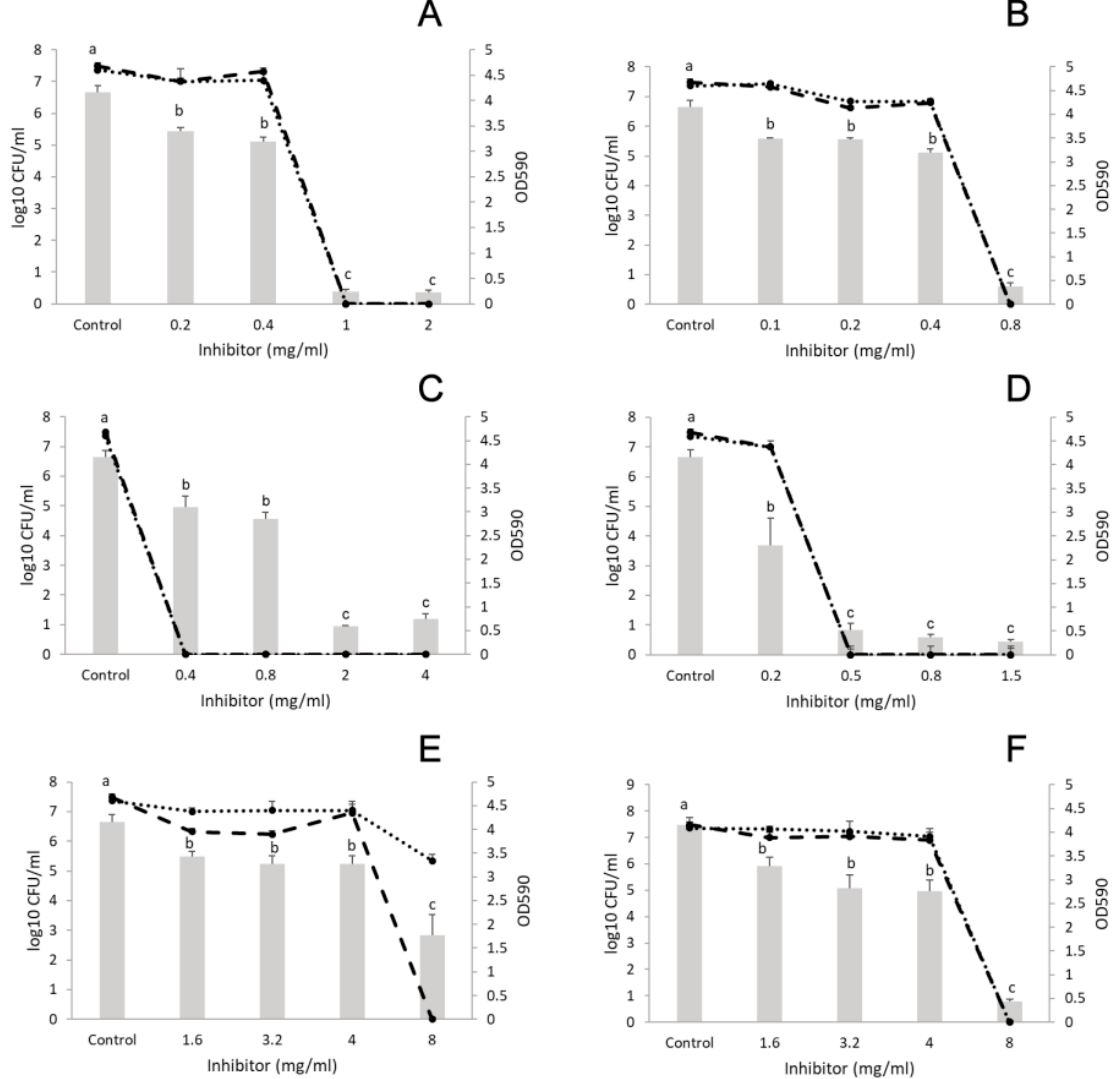
Figure 2. E ff ect of EOs on the biofilm formation of Listeria monocytogenes and Staphylococcus aureus polymicrobial cultures. ( A ) cinnamon EO, ( B ) trans-cinnamaldehyde, ( C ) thyme EO, ( D ) thymol, ( E ) marjoram EO, and ( F ) terpinen-4-ol. Columns represent the OD 590 values, dashed lines represent cell numbers of L. monocytogenes , and dotted lines cell numbers of S. aureus . Results are presented as mean ± standard deviation of six replicates. Di ff erent letters indicate statistically significant di ff erences between columns ( p < 0.05).